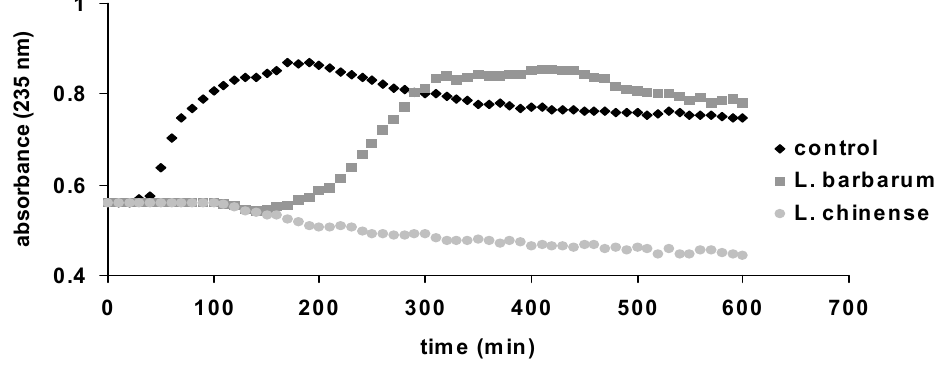
Figure 3. Liposome oxidation by cytochrome c , in the presence of the tested